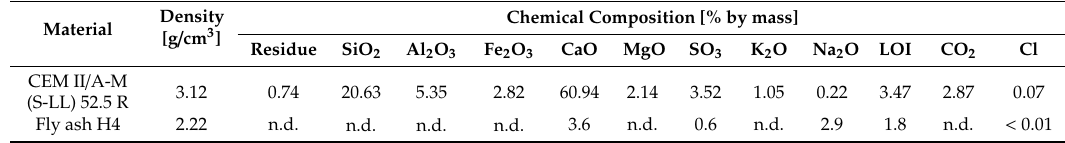
Table 2. Chemical composition of cement and fly ash (LOI = loss on ignition, n.d. = not determined).